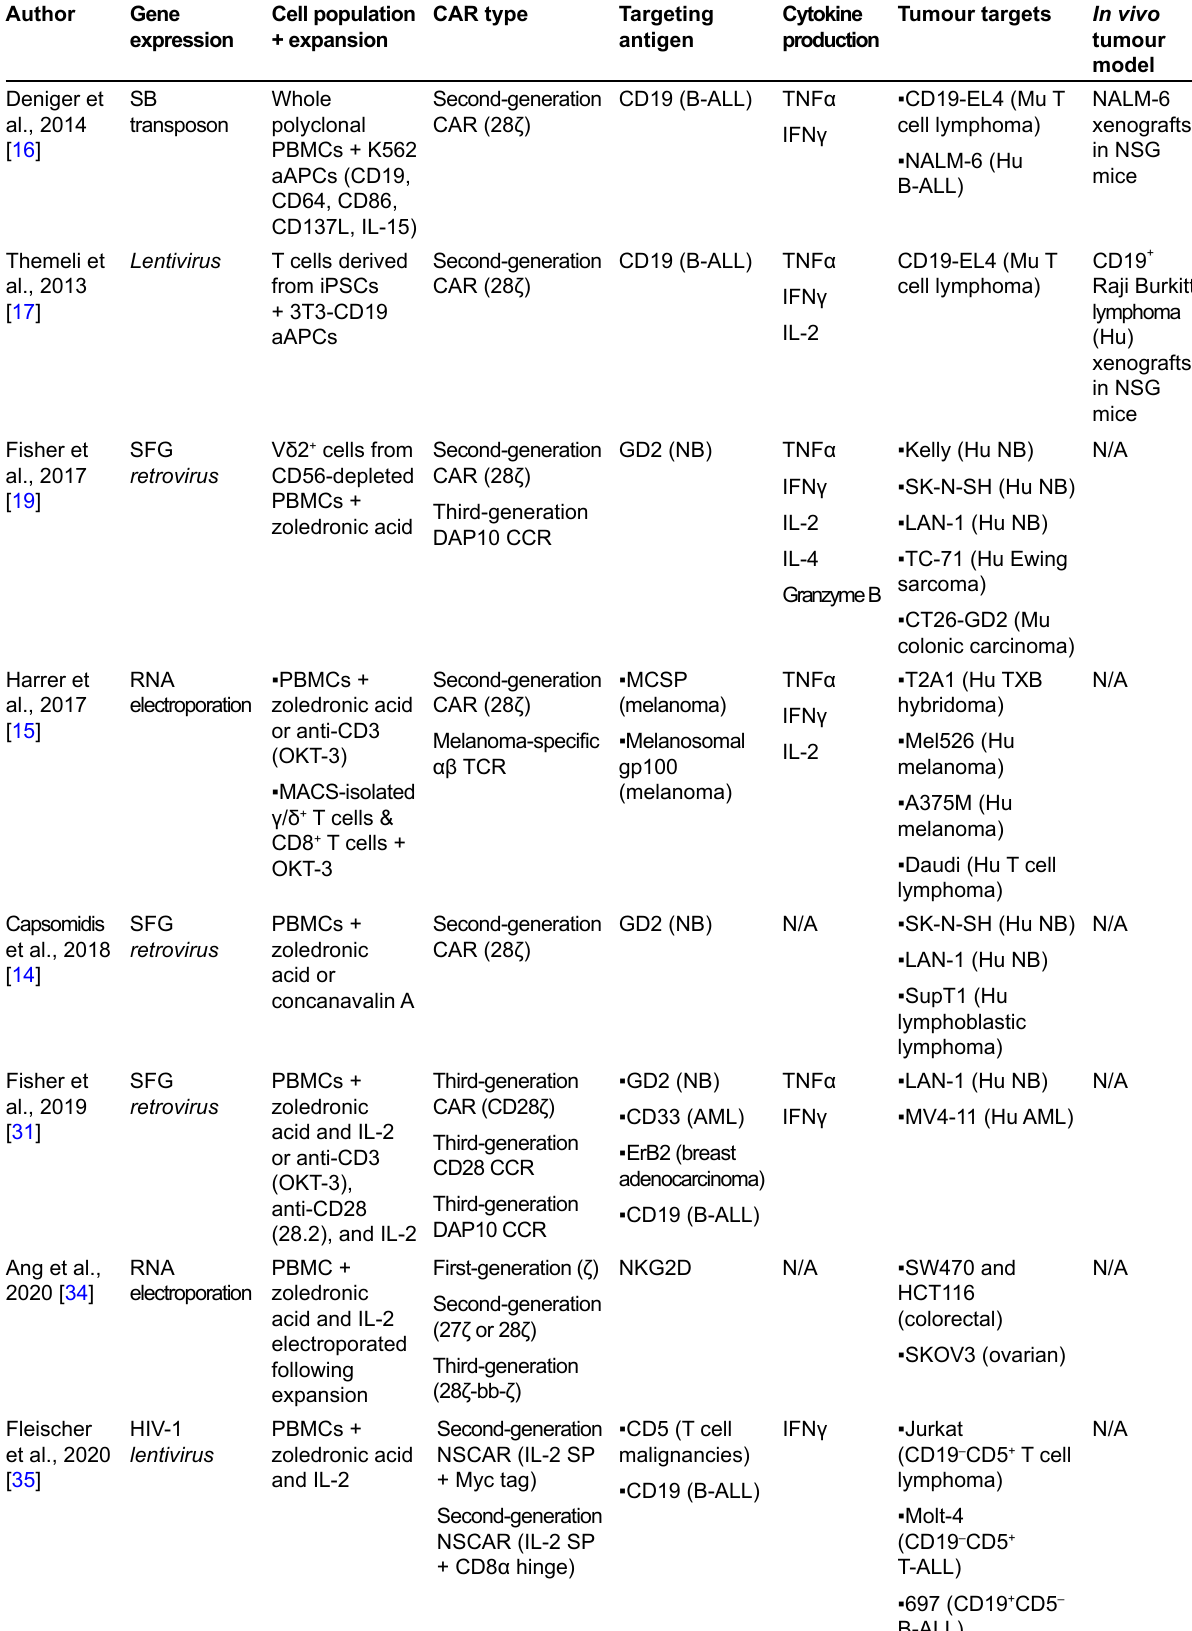
Table 1 . Summary of published studies related to CAR expression in γδ T cells